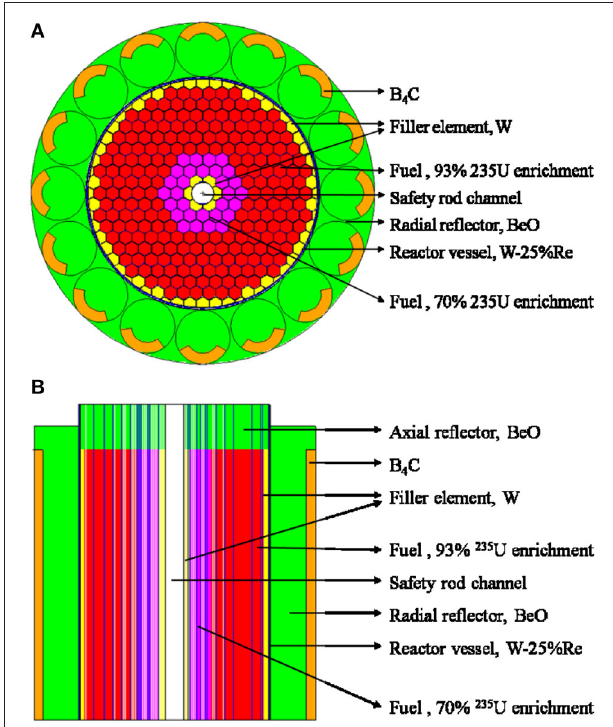
FIGURE 3 | (A) Core configuration in cross-section. (B) Core configuration in